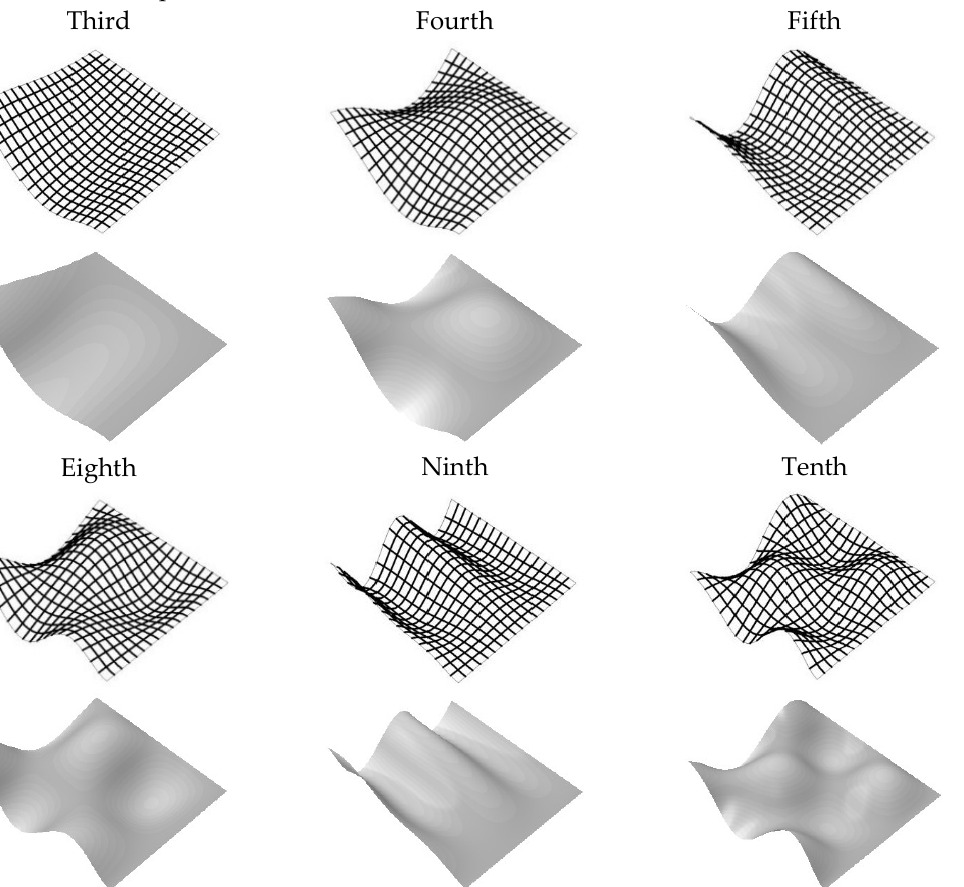
= 0.999999 and r = x 0 y 0